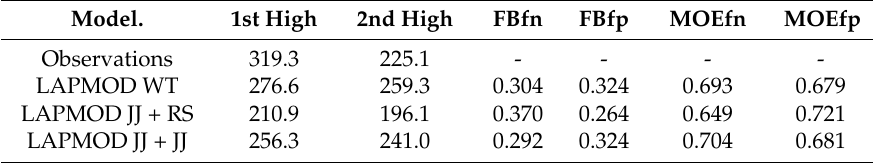
Table 5. Performance statistics of LAPMOD for the Kincaid SF 6 observations of best quality. Model.